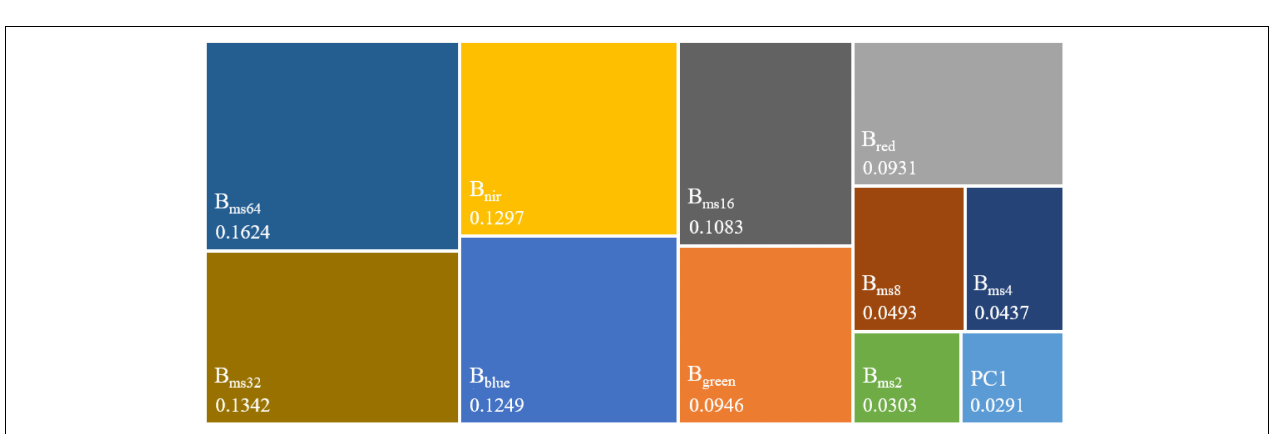
FIGURE 8 | The Gini -importance of image features. B blue , B green , B red , and B nir are the bands of GF-2 multispectral image. PC1 is the first principal component image.